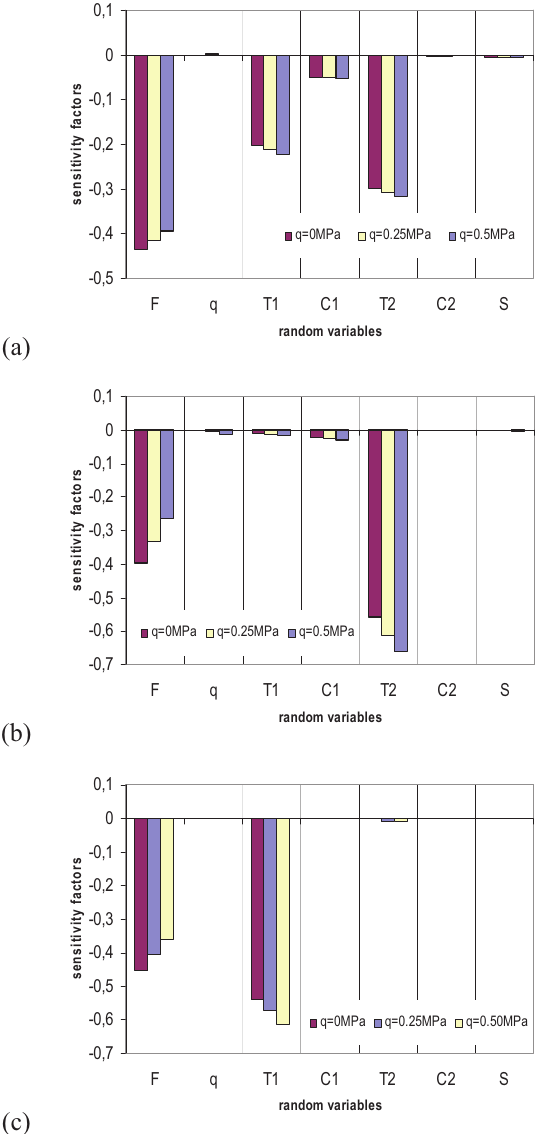
Fig. 11. Sensitivity analysis with respect to standard devia- tion of random variables ( P f ≈ 10 − 2 ): (a) carbon-epoxy, (b) glass-epoxy, (c)